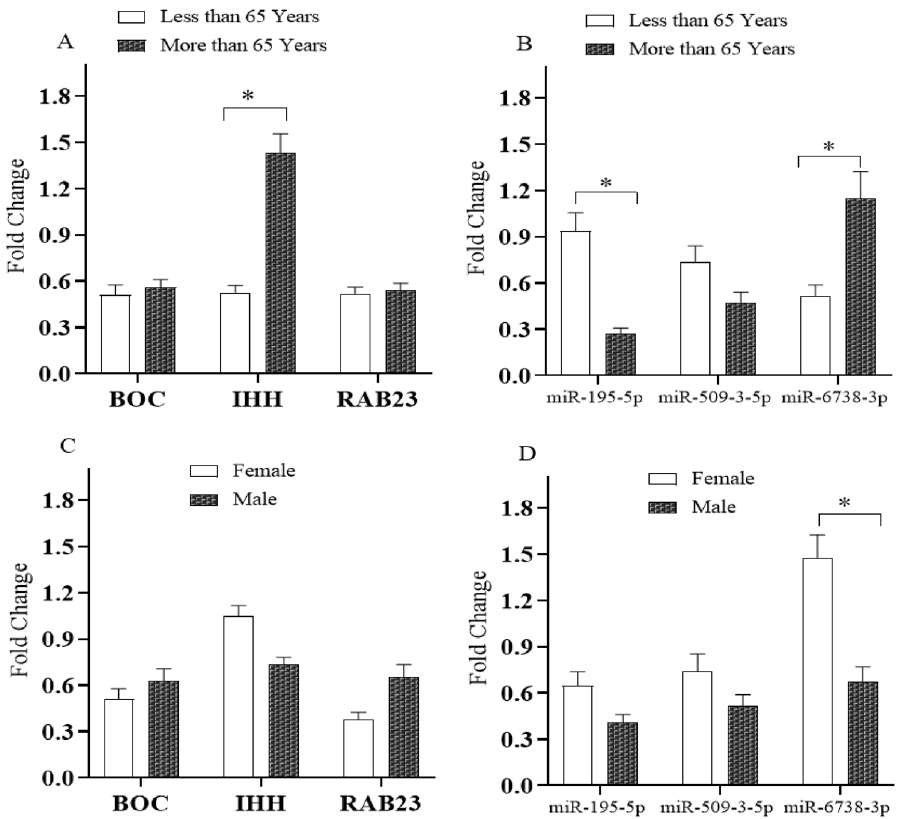
Figure 5. Association of the Shh signaling pathway genes and their regulatory miRNAs expression fold changes in tumoral tissues compared with their adjacent non-tumoral counterparts with age (< 65 years and ≥ 65 years) and gender. * indicates significant difference P <